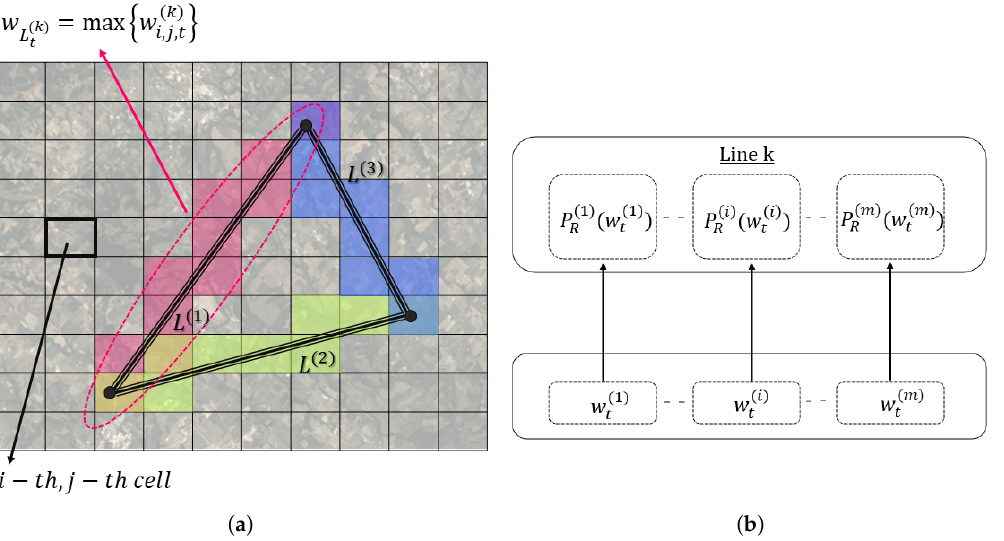
Figure 10. Proposed and future trend-approaches in transmission line modeling. ( a ) Wind spatial characterization on the network. Dotted red circle: proposed approach. Colored cell: Finer mesh approach. ( b ) Piece-wise line model with finer mesh